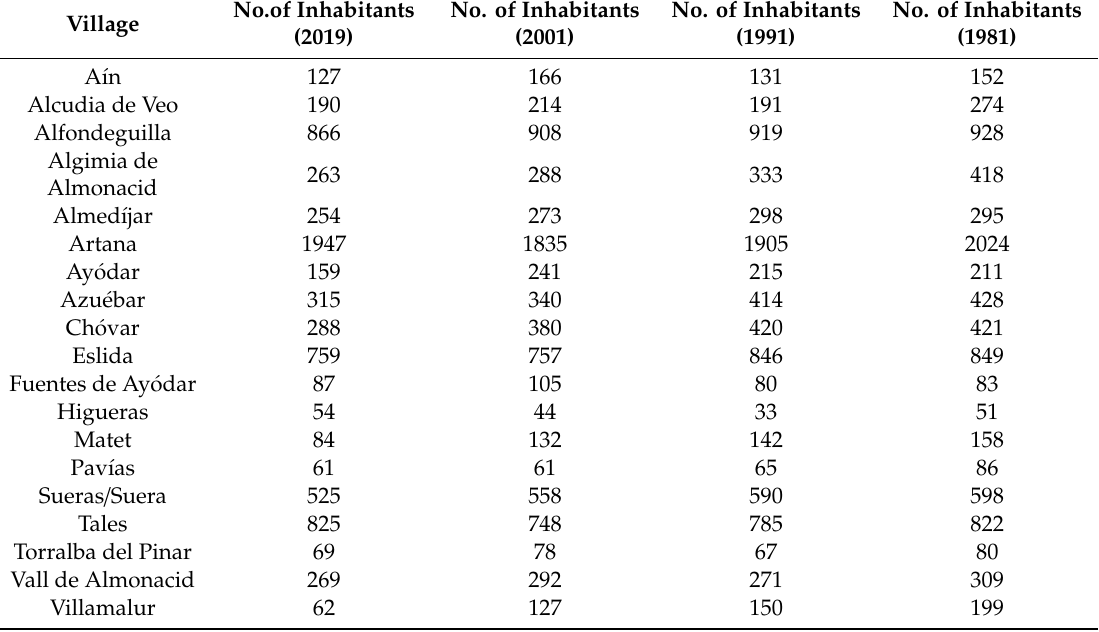
Table 1. List of villages and number of inhabitants (years 2019, 2001, 1991,1981) belonging to the Sierra de Espad á n Natural